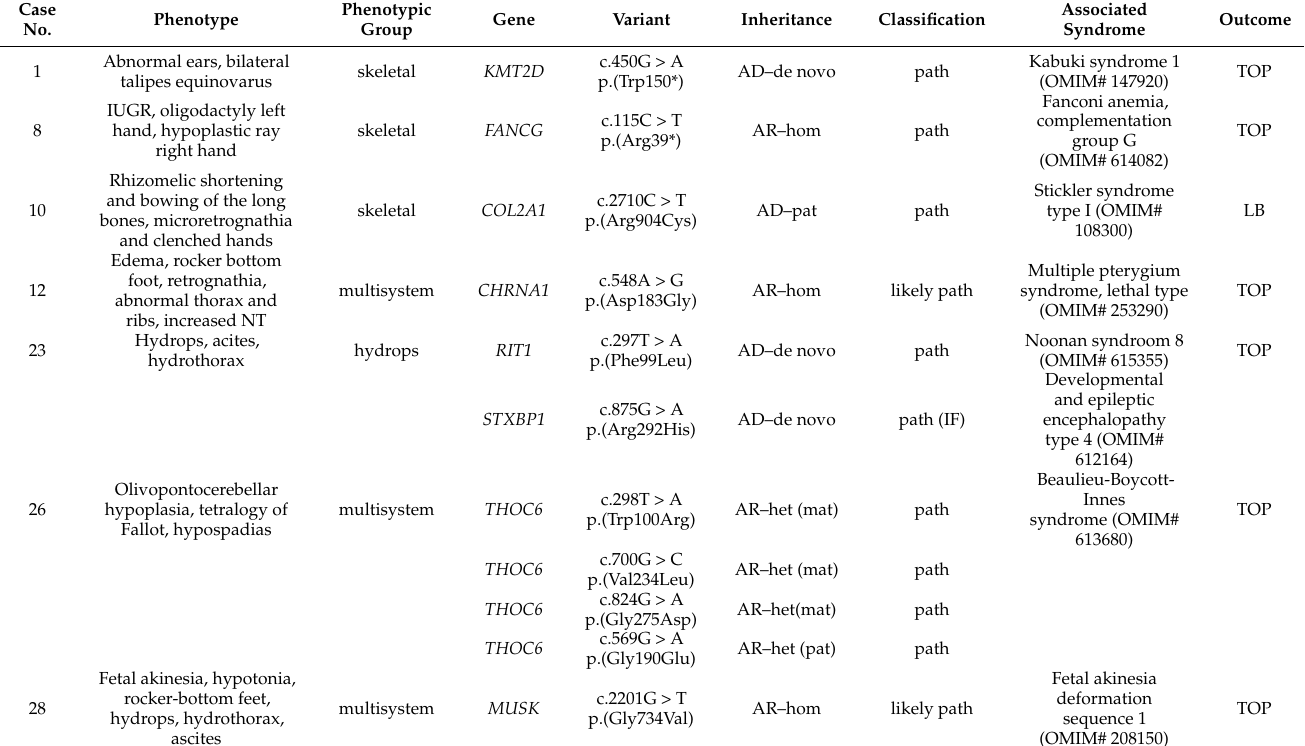
Table 1. Prenatal cases for which WES demonstrated a likely pathogenic or pathogenic variant. For each case, the fetal phenotype and the organ system involved are described and the affected gene and variant, the inheritance mode, the associated syndrome and the outcome of the pregnancy are listed. AD: autosomal dominant; AR: autosomal recessive; hom: homozygous; IF: incidental finding; IUGR: intrauterine growth restriction; LB: live birth; mat: maternal; NT: nuchal translucency; pat: paternal; path: pathogenic; TOP: termination of